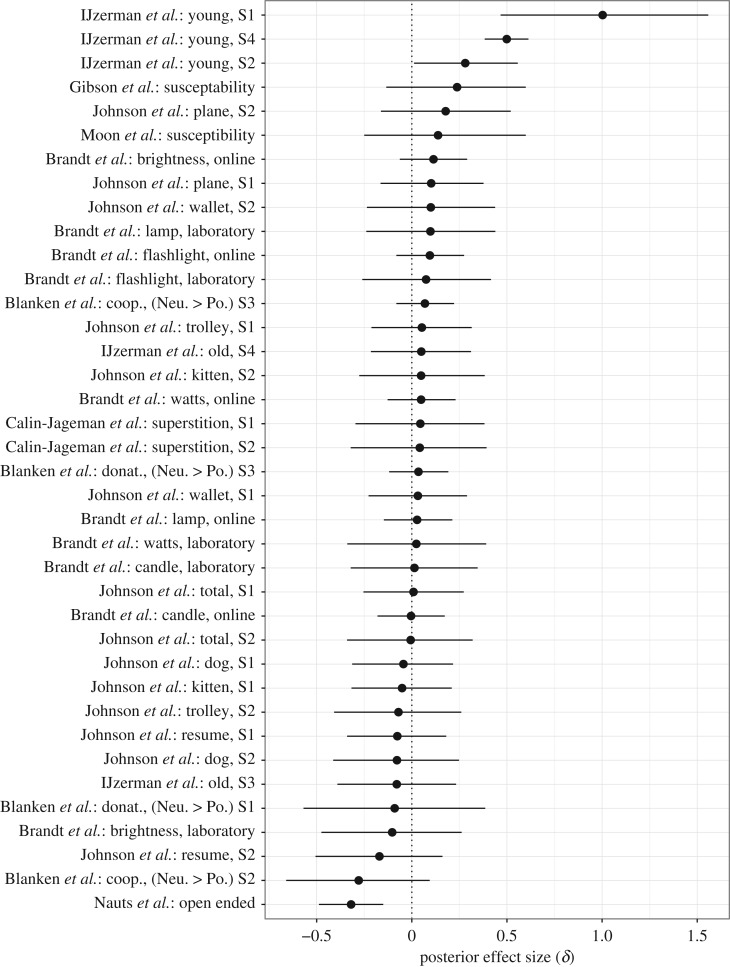
Individual Bayesian parameter estimation results for directed effect sizes δ for each of 38 experiments reported in the Social Psychology special issue that used t-tests. The posterior medians are indicated as dots and the central 95% credible intervals as vertical lines. The effect sizes were estimated using separate unrestricted models, but recoded such that they are predicted to be positive. Figure available at https://flic.kr/p/FQJrUr, under CC license https://creativecommons.org/licenses/by/2.0/.